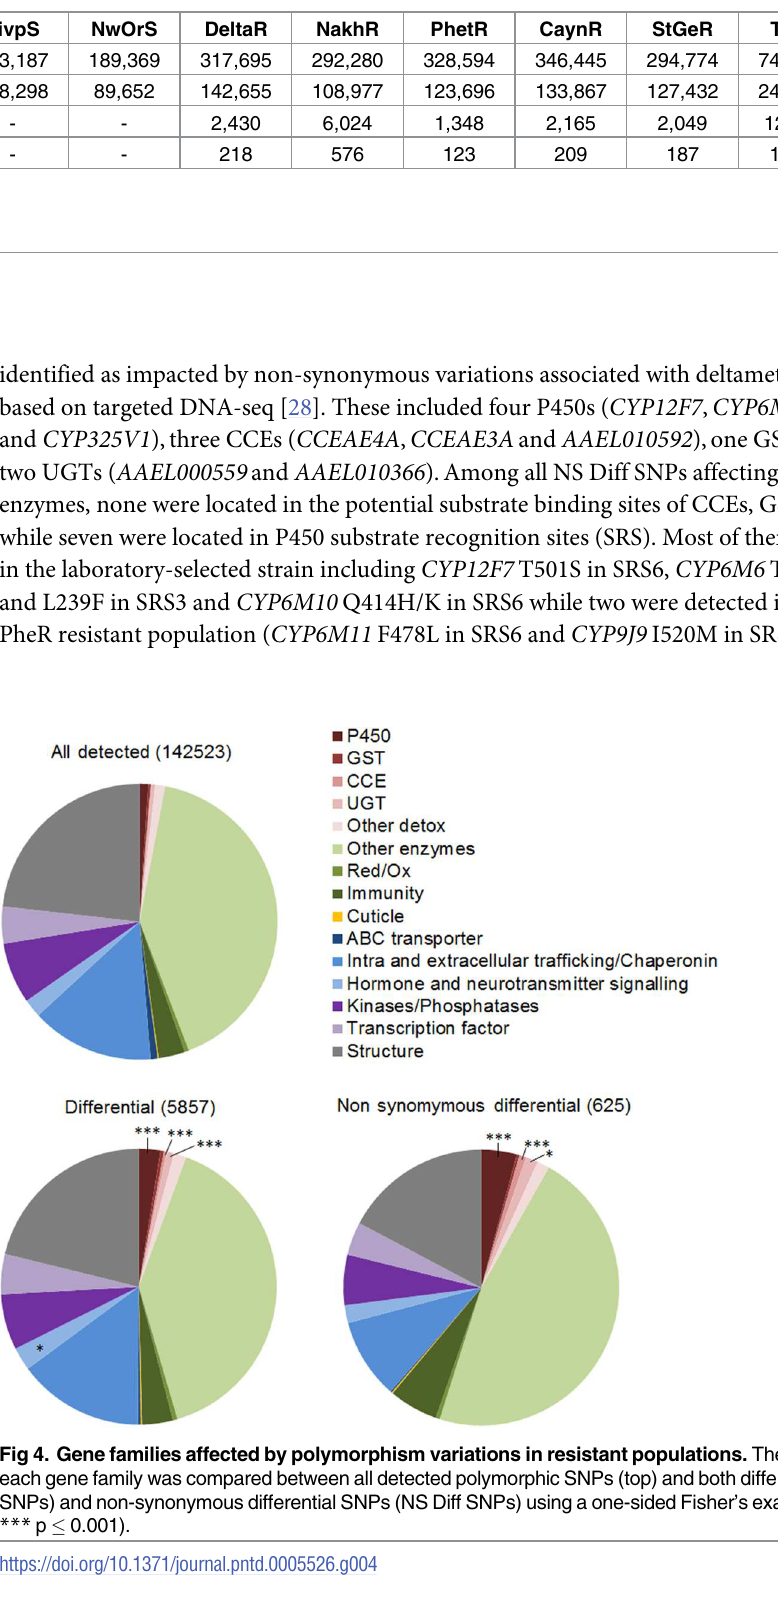
Table 3. Overview of SNP analysis.